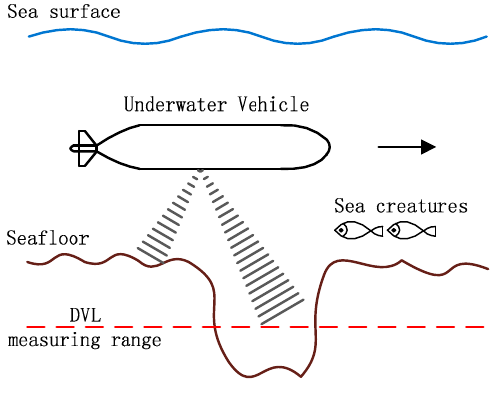
Figure 1. DVL malfunction circumstances.